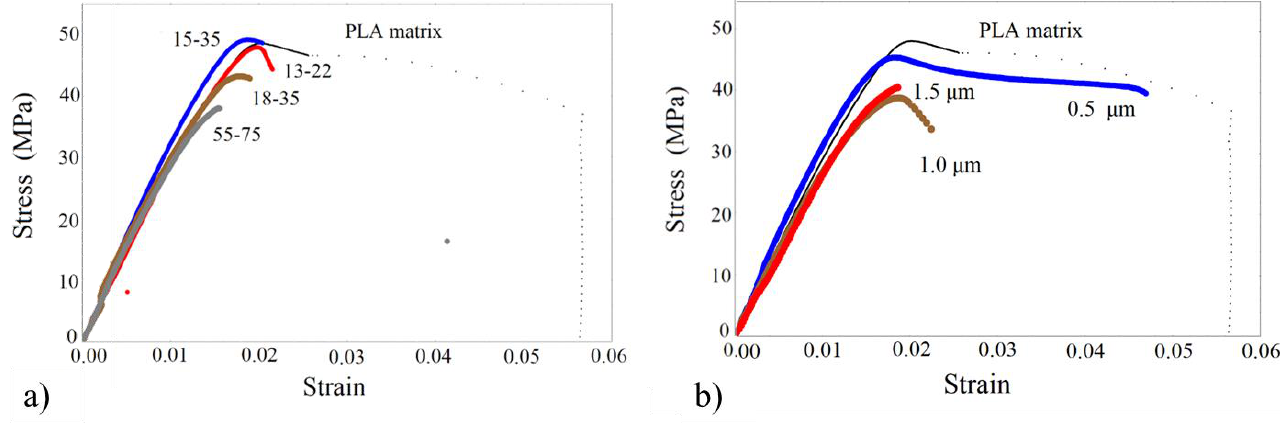
Figure 5. Tensile stress-strain curves of ( a ) PLA/silica nanocomposites, ( b ) PLA/silica micro-compo- sites.